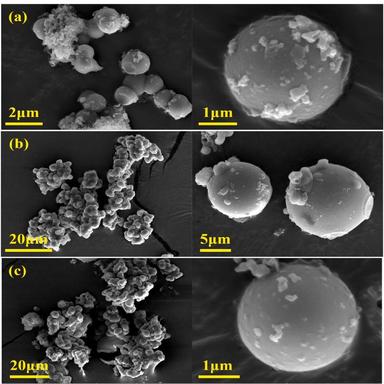
SEM images of (a) MicroEPCM-2%BN; (b) MicroEPCM-4%BN; (c) MicroEPCM-6%BN.